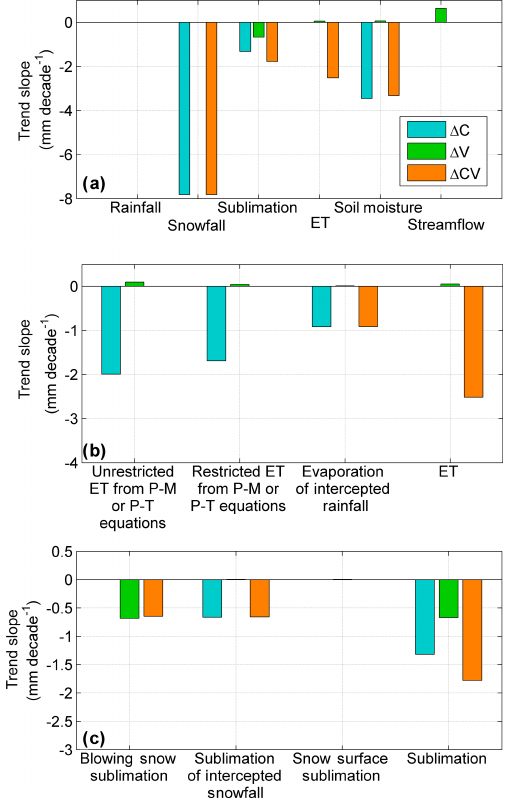
Figure 8. Comparison of basin-scale annual mass fluxes trends ( p ≤ 0 . 05) over the water years from 1960 to 2015, for the three sce- narios. (a) Main mass fluxes. (b) Evapotranspiration components. (c) Sublimation